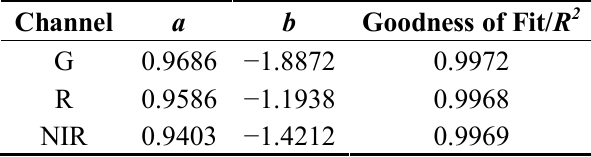
Table 4. Linear correlation coefficients of bank0 and